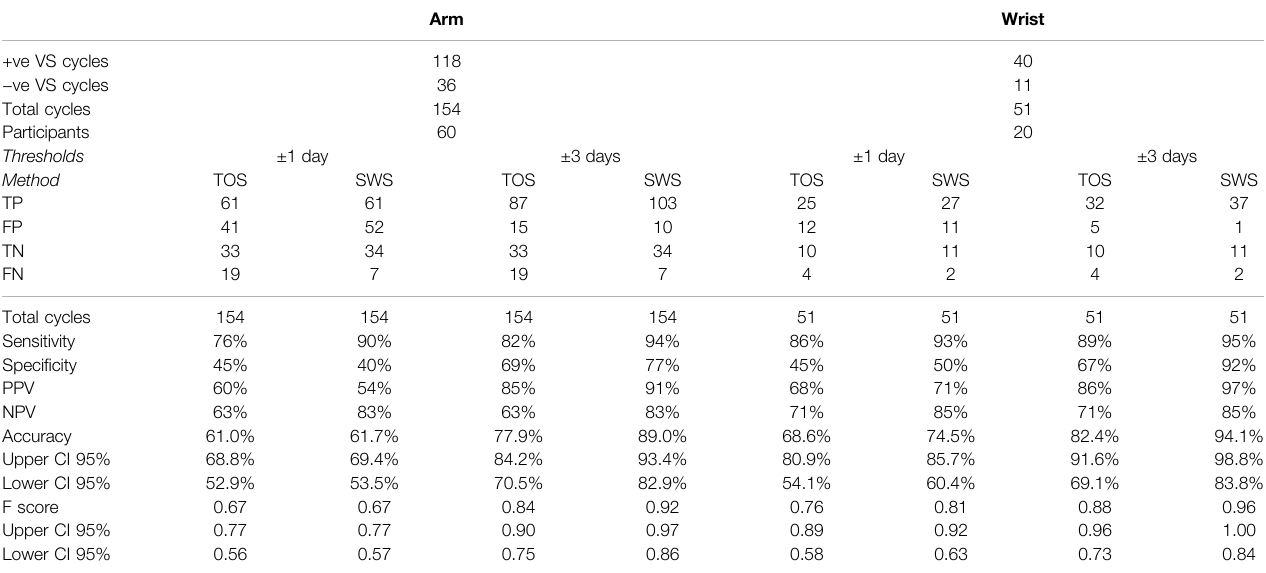
TABLE 8 | Threshold method results for TOS and SWS compared with VS for skin site.